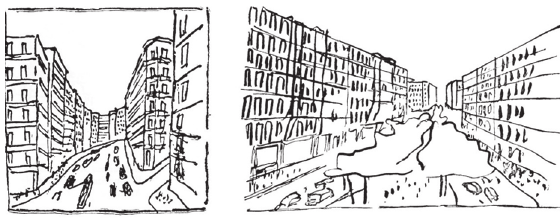
fig. 7. Two drawings of a ‘rue corridor’ (le Corbusier 1946a) (de Pierrefeu, le Corbusier 1942)